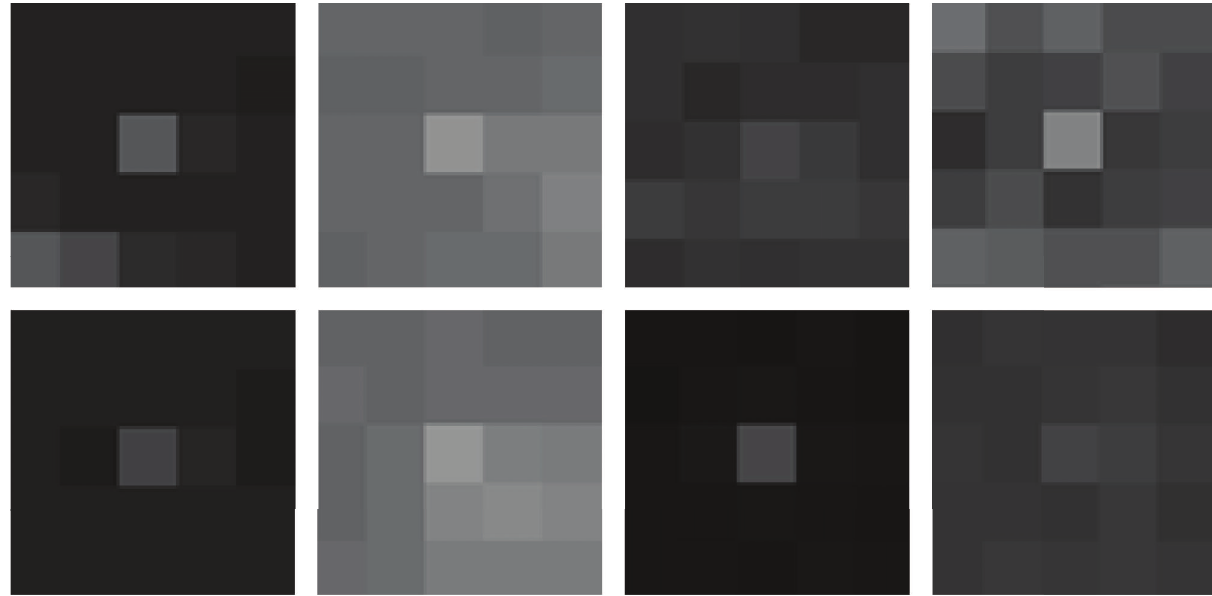
Figure 2: Targets in their local areas.